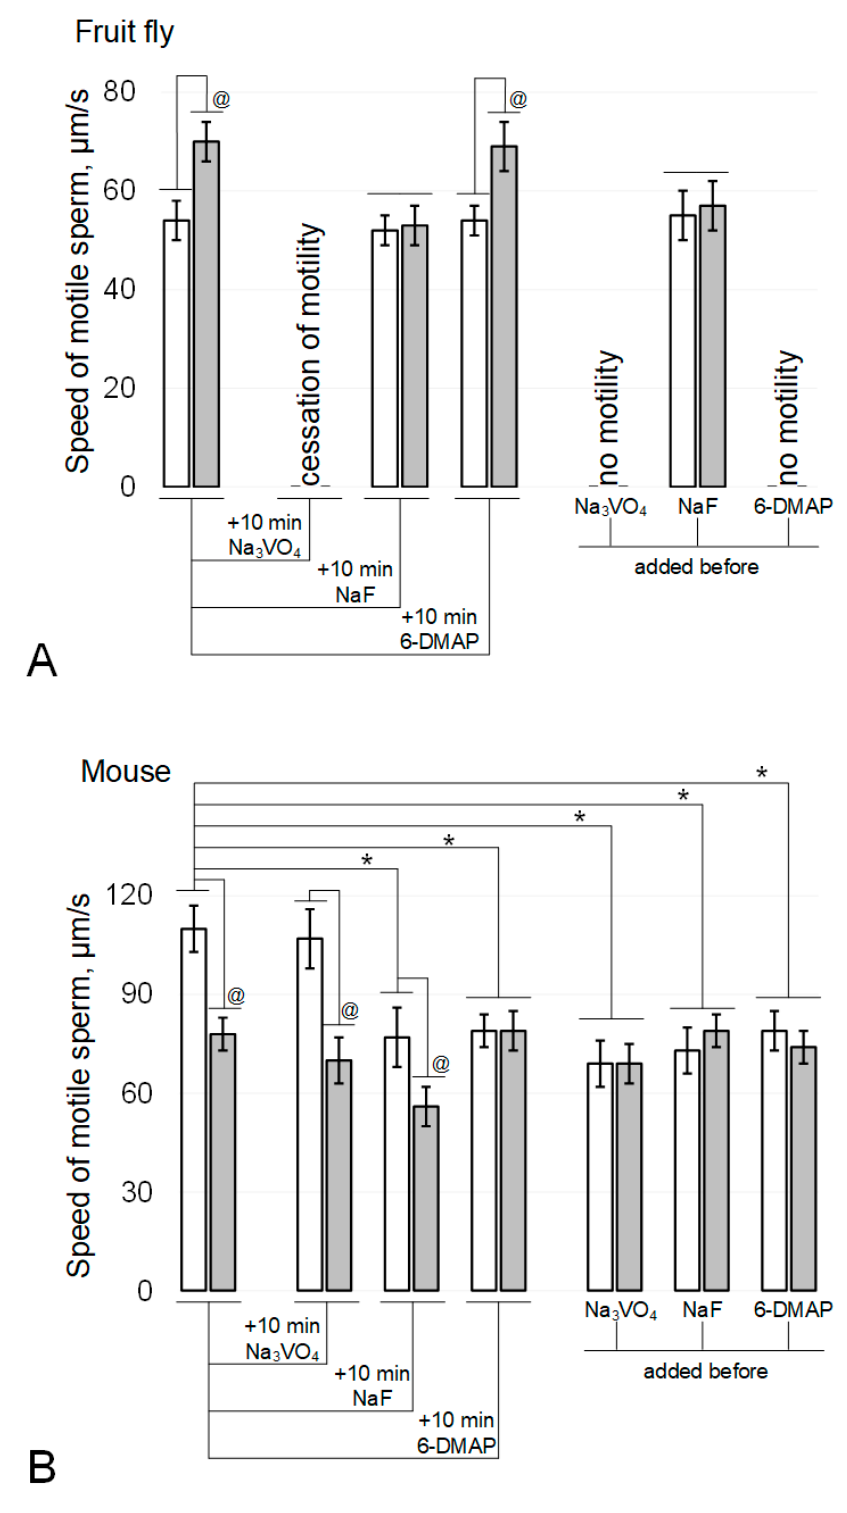
Figure 1. Sperm motility after 6-h modelling microgravity. ( A ) fruit fly Drosophila melanogaster. ( B ) mouse. White columns—control, grey columns—after 6 h exposure under modelling microgravity conditions. Na3VO4—200 µM sodium orthovanadate (Tyr phosphatase inhibitor). NaF—5 mM sodium fluoride (Ser/Thr phosphatase inhibitor). 6-DMAP—0.5 mM 6-(dimethylamino)purine (protein kinase inhibitor). @ p < 0.05 in comparison with according control group, * p < 0.05 in comparison with control without any inhibitors.